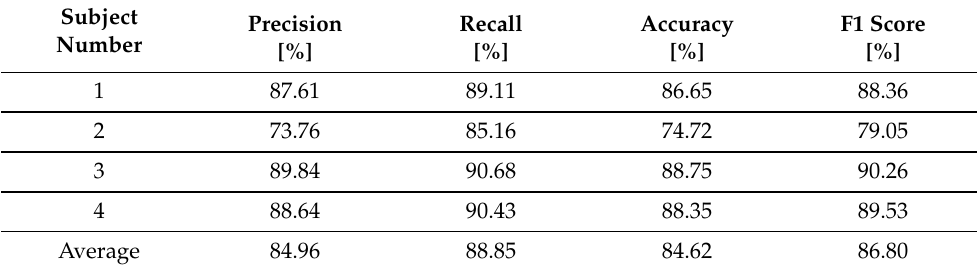
Table 1. Experimental results for test set single-subject model.